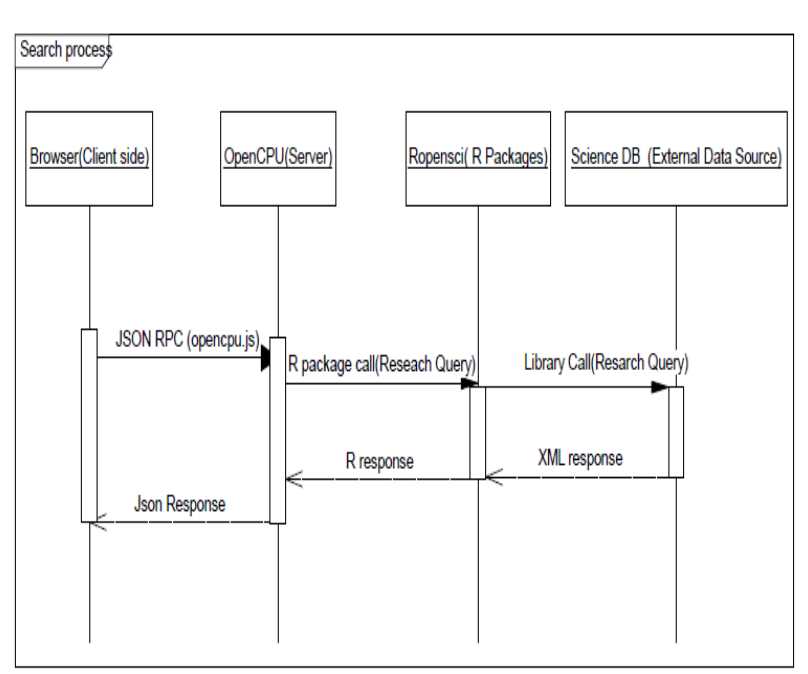
Fig. 3. Sequence diagramme for search process on the